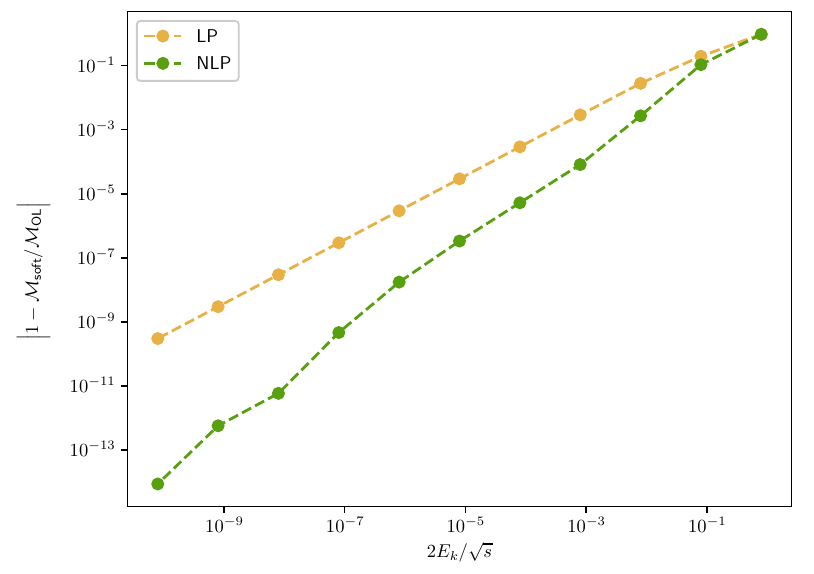
Figure 6 . Convergence of the soft limit value OL is calculated with OpenLoops using quadruple M